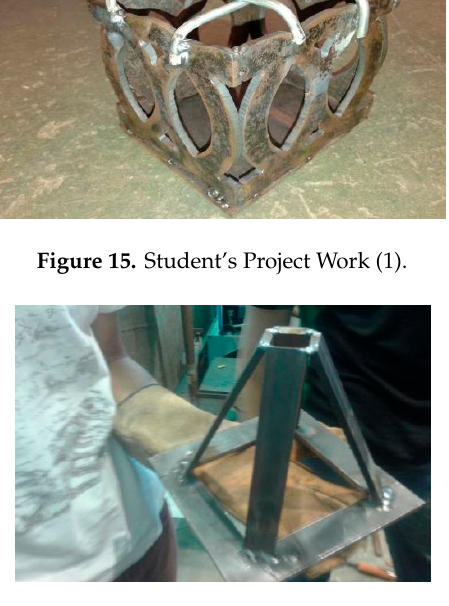
Figure 16. Student’s Project Work (2).